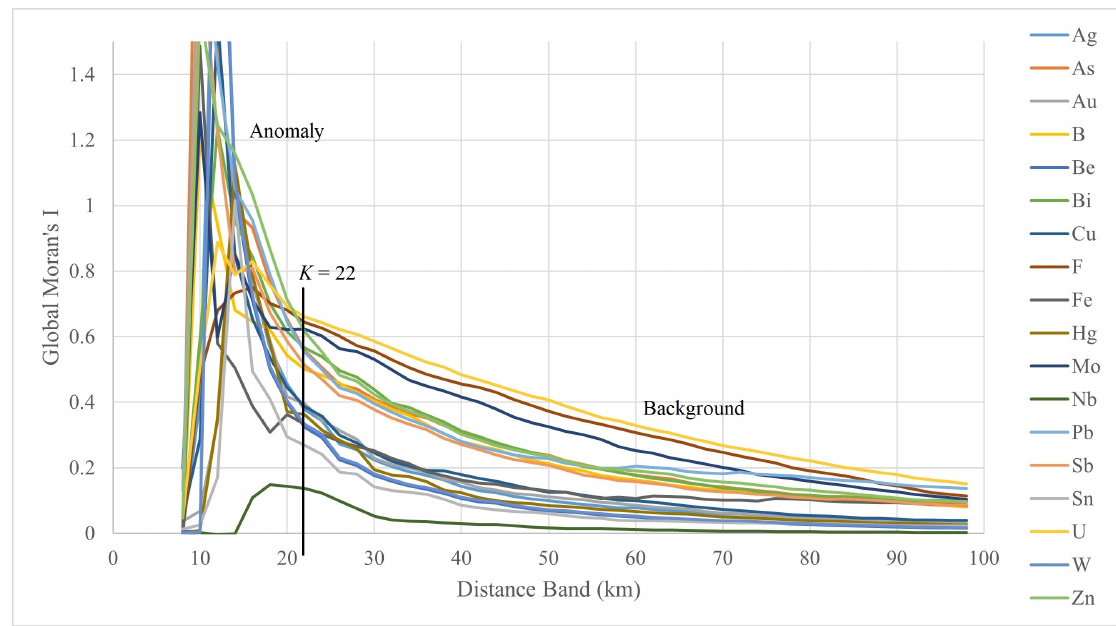
Figure 3. Variation in global Moran’s I index with different distance bands (namely K ).